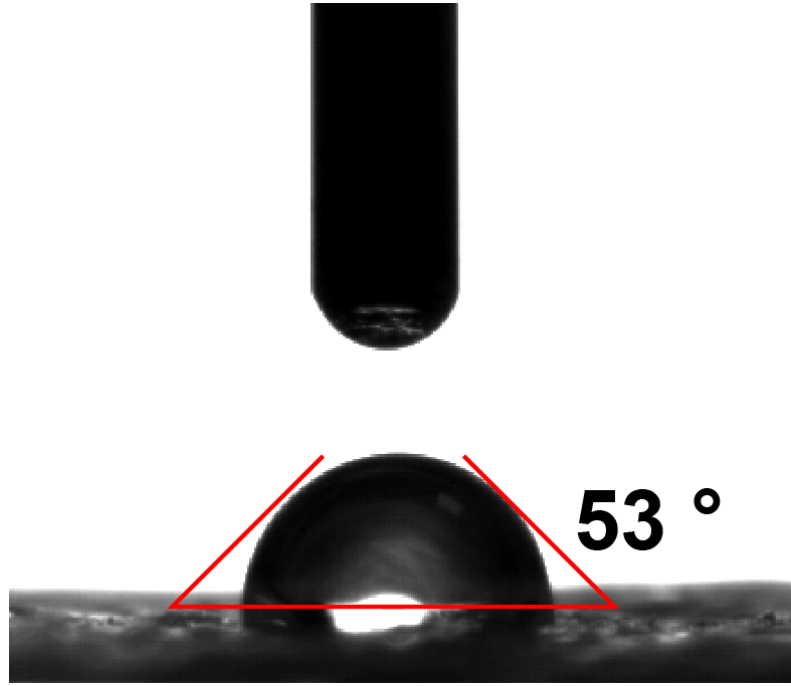
Figure 10. Contact angle test of RGM.